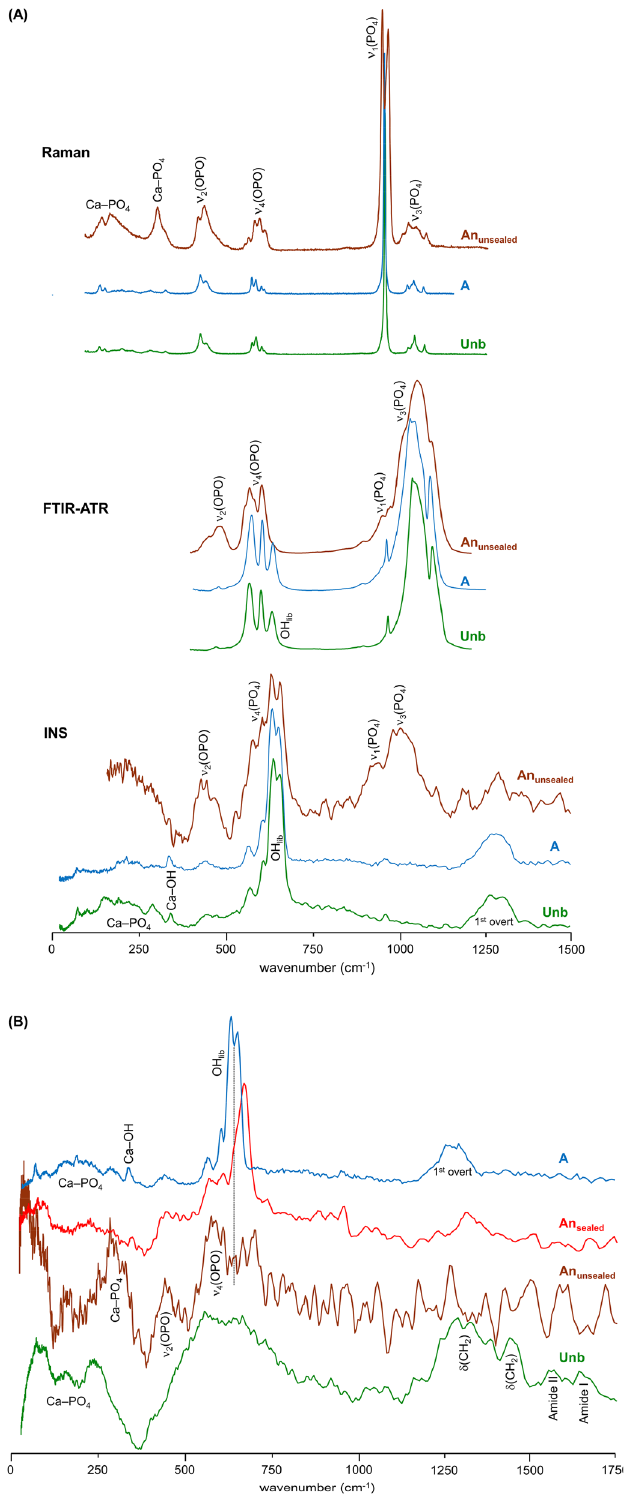
Figure 4. ( A ) INS (measured in TOSCA), FTIR-ATR and Raman spectra of reference calcium hydroxyapatite (SRM 2910b, HAp)—unburned (Unb, green), and burned at 1000 °C under aerobic (A, blue) and anaerobic/ unsealed conditions (An unsealed , brown); ( B ) INS spectra (measured in TOSCA) for human femur, unburned (Unb, green) and burned at 1000 °C under anaerobic/unsealed (An unsealed , brown), anaerobic/sealed (An sealed , red) and aerobic (A, blue)